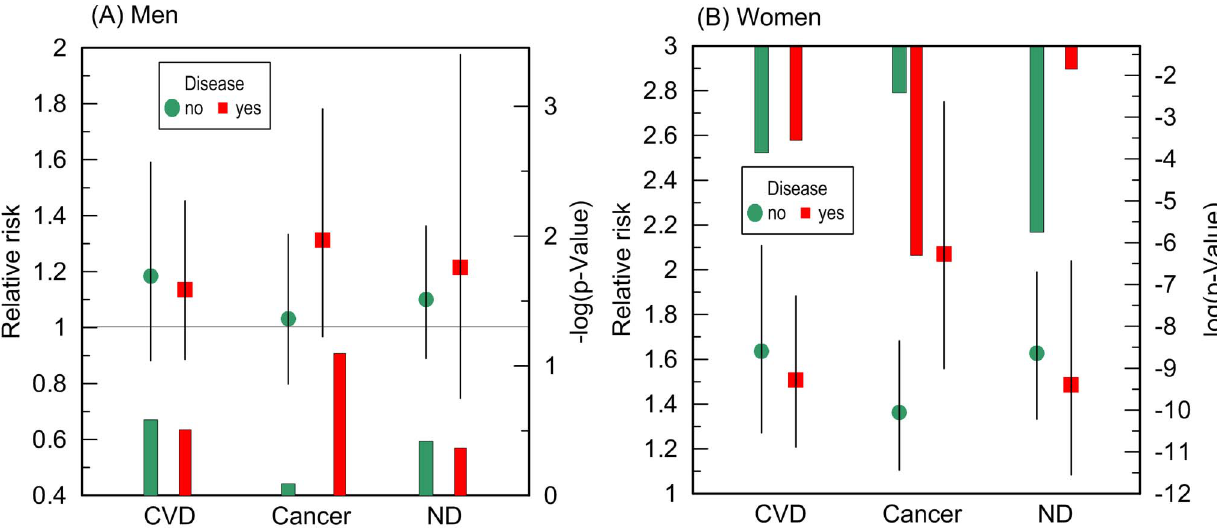
Figure 4. Disease-stratified relative risks of death and p-values for the ApoE4 allele carriers compared to the non-carriers. The risks were evaluated in a more homogeneous group of (A) men and (B) women who died or were right censored at ages 70 to 95 years in the pooled sample of the FHS and FHSO cohorts. The models were adjusted for birth cohorts, an indicator of the FHS or FHSO, and additive contributions of CVD, ND, and cancer, as applicable, e.g., the model for samples stratified by CVD was adjusted by cancer and ND. Multiplicative interaction between ApoE and cancer for women is significant (p=0.029). Thin bars show 95% confidence intervals. Exact numeric values for the estimates and sample size are given in Table 3. Right y-axes show (A) minus log-base-10-transformed p-values and (B) log-base-10-transformed p-values. (A) The horizontal line and (B) upper x-axis show the conventional level of significance, i.e., |log 10 (0.05)|=1.3.